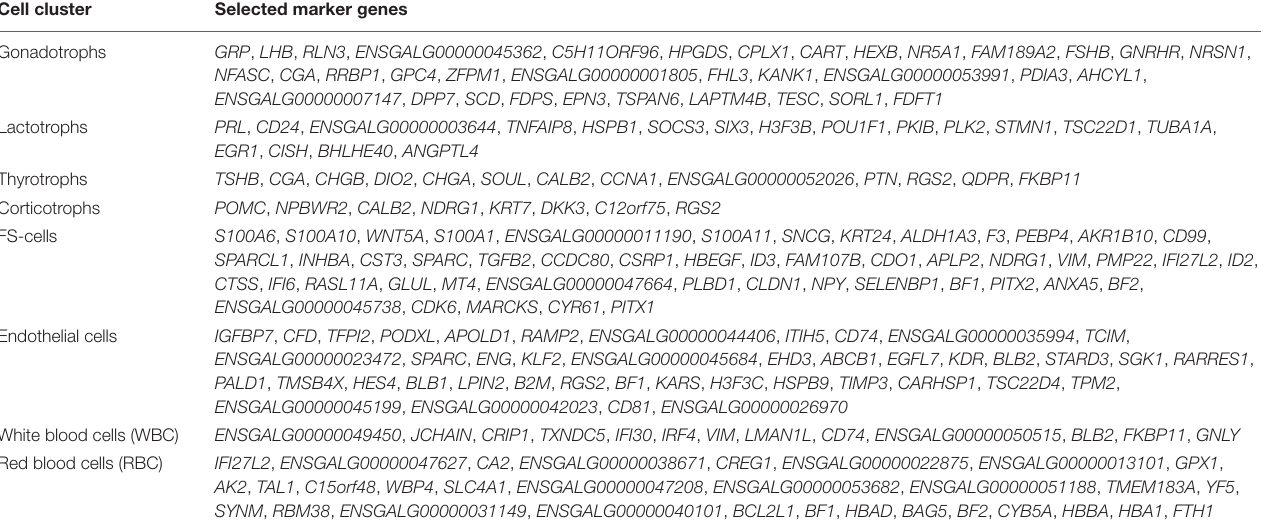
TABLE 1 | Selected marker genes identified in eight chicken anterior pituitary cell